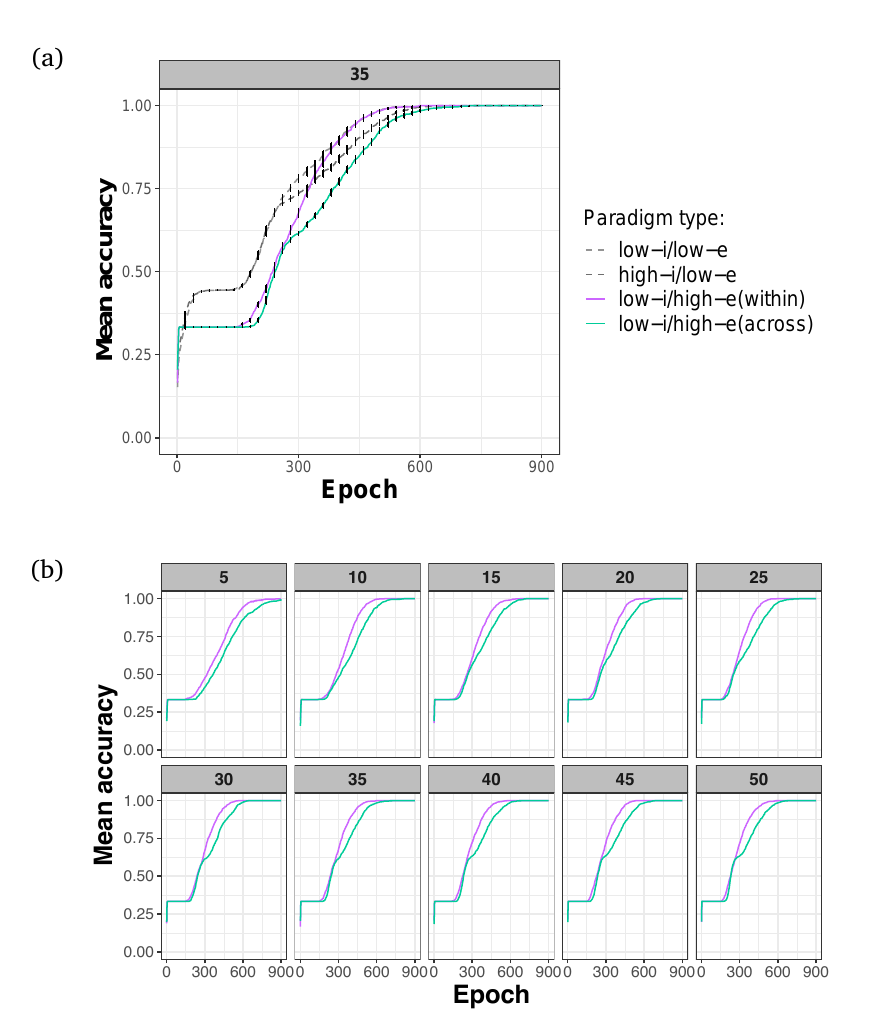
Network learning trajectories with low-i/high- e low-i/high- e paradigms plotted separately. Trajectories for networks across trained on low-i/low-e and high-i/low-e paradigms presented in grey (dashed lines) for comparison. (a) results for one network size (35 cells), with error bars indicating standard error every 10 epochs. (b) results for all network sizes tested (facet titles give network size in number of cells). Networks trained on paradigms with cross-class syncretism show slower learning